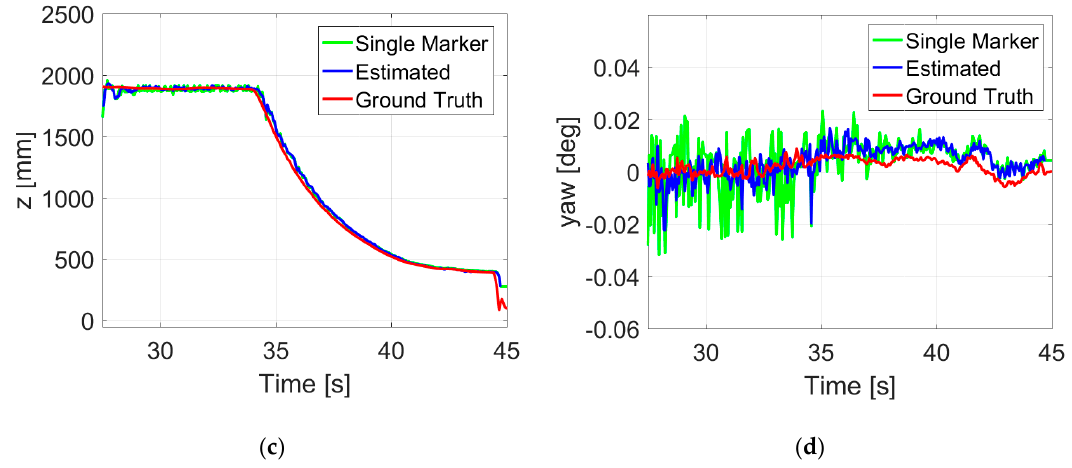
Figure 13. Position ( a,b,c ) and yaw angle ( d ) estimates during an autonomous landing.